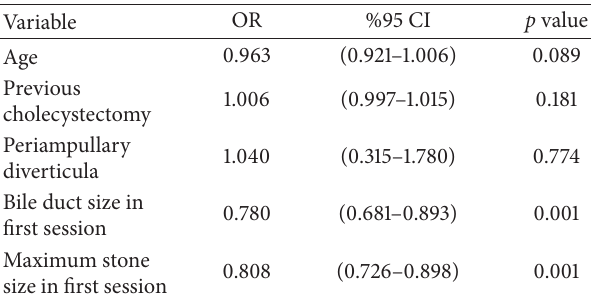
Table 3: Multivariate analysis for factors affecting endoscopic